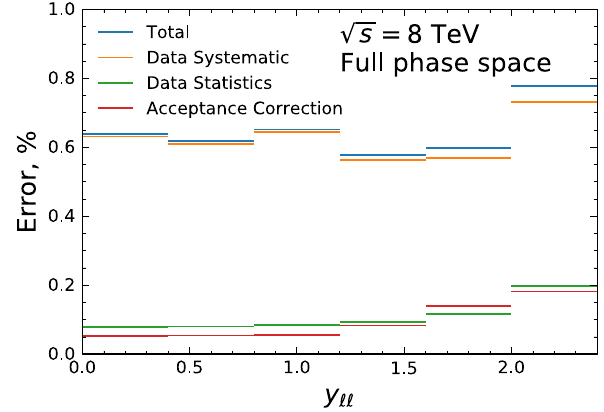
Fig. 6 Ratios of differential d σ/ d p (cid:4)(cid:4) full phase space distributions T Fig. 7 Decomposition of the uncertainties for the d σ/ d y (cid:4)(cid:4) measure- for different y (cid:4)(cid:4) bins to the 0 < y (cid:4)(cid:4) < 0 . 4 bin. The error bars show ment. The global normalization uncertainty due to the luminosity mea- total uncertainties of individual d σ/ d p (cid:4)(cid:4) measurements. The horizontal T surement of 1 . 9% is not shown lines shown for p T > 35 GeV represent NLO predictions for Z plus jet process using CT14NNLO PDF set